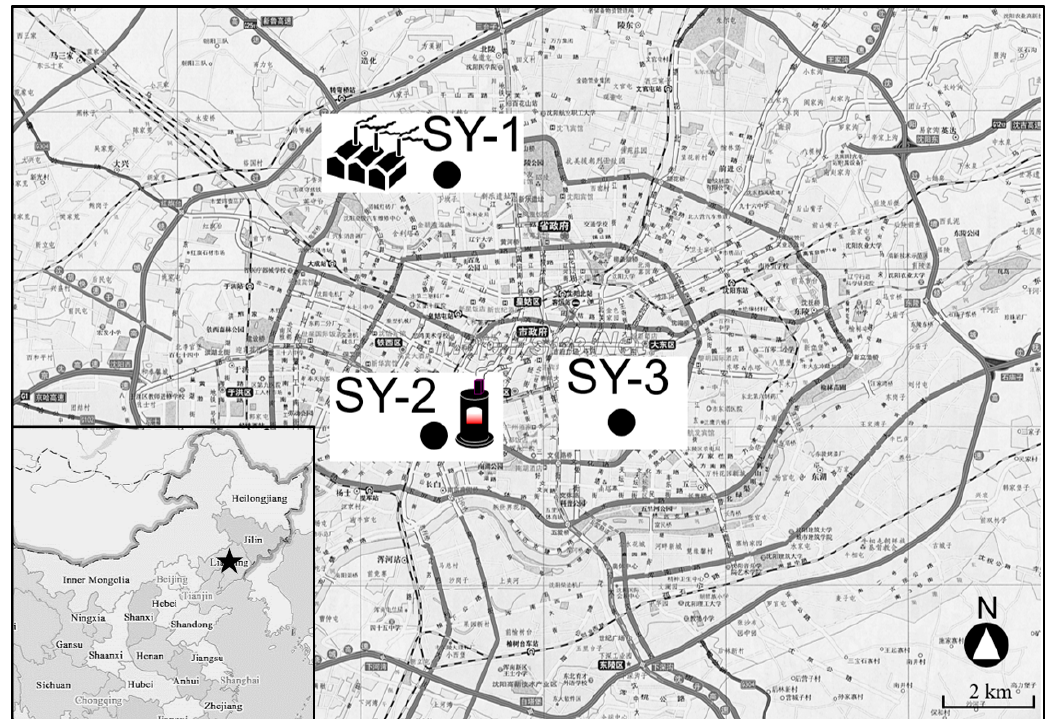
Figure 1. Locations of the three typical sampling areas in Shenyang, China.